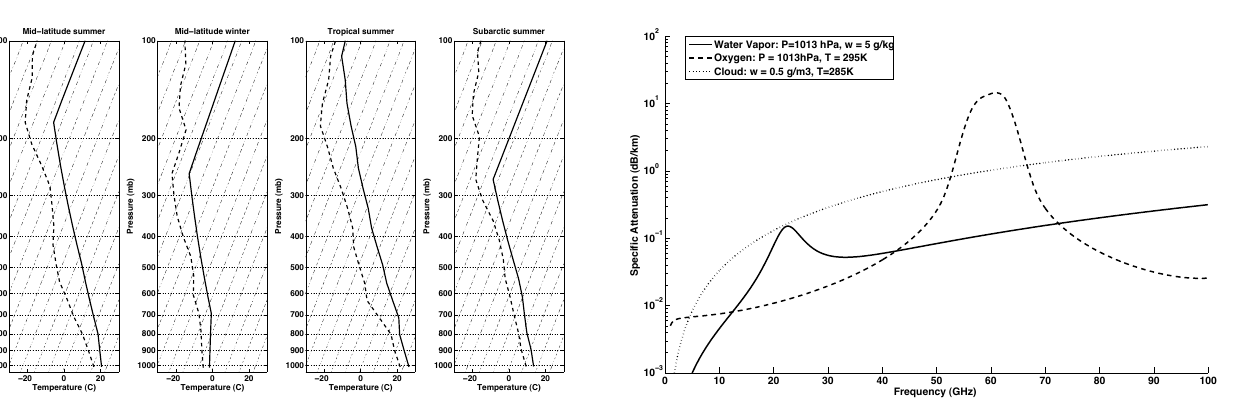
Fig. 3. One-way specific attenuation curves of water vapour Figure 3. One-way specific attenuation curves of water vapor (dashed), oxygen (line) and 5 (dashed), oxygen (line) and cloud (dotted) in dBkm − 1 . cloud (dotted) in dB/km. 6 being separated by 0.1 GHz. The beam widths chosen range from 0.5 to 10 ◦ at half power full width, while the channel bandwidths range between 100 and 1000 MHz. These set- tings cover the specifications of current microwave instru- ments. The elevation angles from 0.5 to 90 ◦ are chosen to emphasise the low elevation scans required when perform- ing boundary layer scans or when scanning with radars.